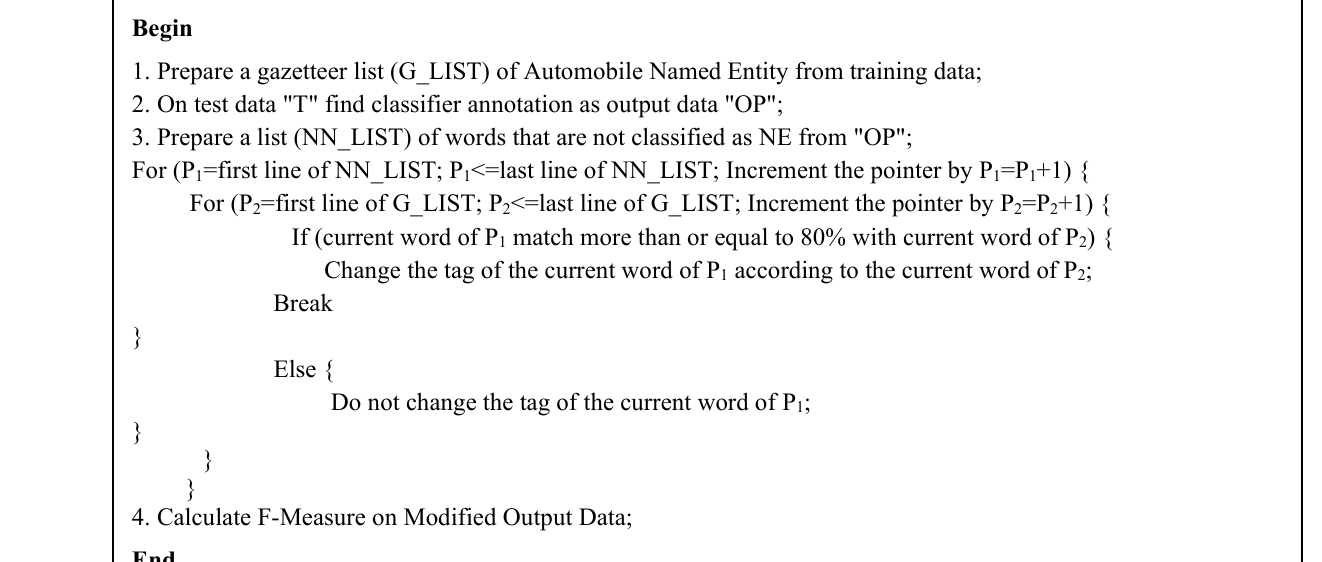
Algorithm 1. String Matching Based Noisy Name